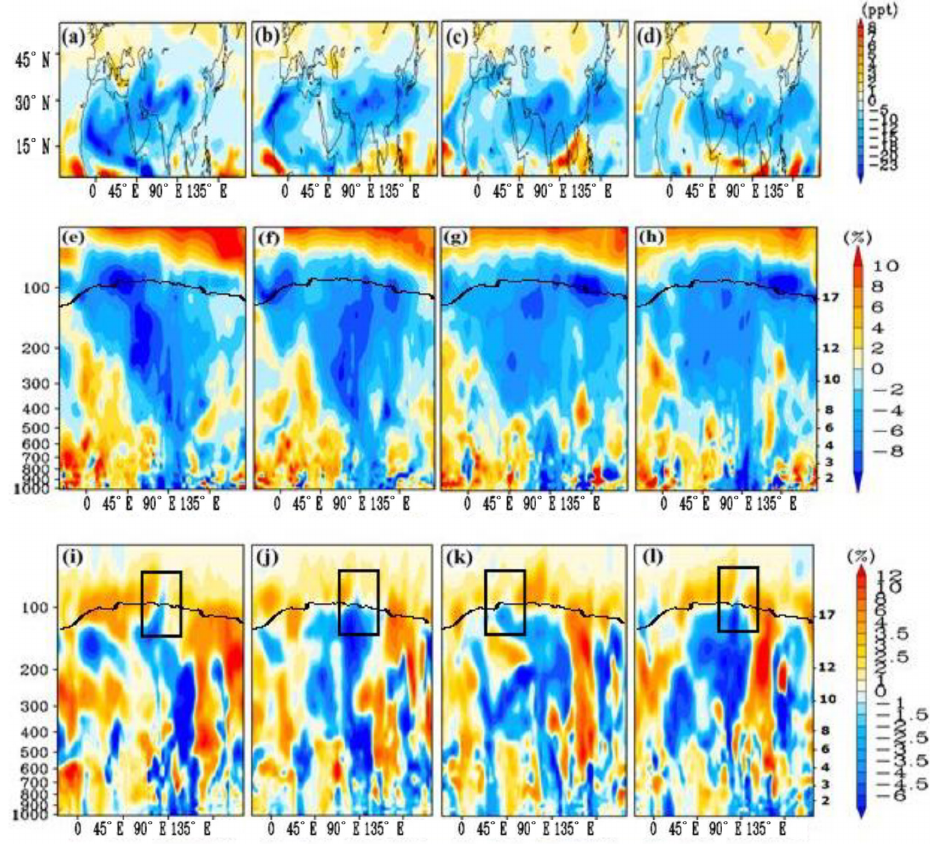
Figure 8. Spatial distribution of anomalies (Asia-10-CTRL) of PAN mixing ratios (ppt) (colour shades) at 16km from ECHAM5-HAMMOZ model simulations for (a) 2 July, (b) 4 July, (c) 6 July, (d) 8 July 2003. Longitude-pressure distribution (averaged for 20–40 ◦ N) of anomalies of PAN (%) for (e) 2 July, (f) 4 July, (g) 6 July and (h) 8 July 2003. Panels (i) – (l) are the same as (e) – (h) but for ozone anomalies (%) (averaged for 18–20 ◦ N). Thick black line indicates the tropopause. Pressure (hPa) is indicated on the left y axis and altitudes (km) on the right y axis. Black boxes in the bottom panels indicate regions of cross-tropopause